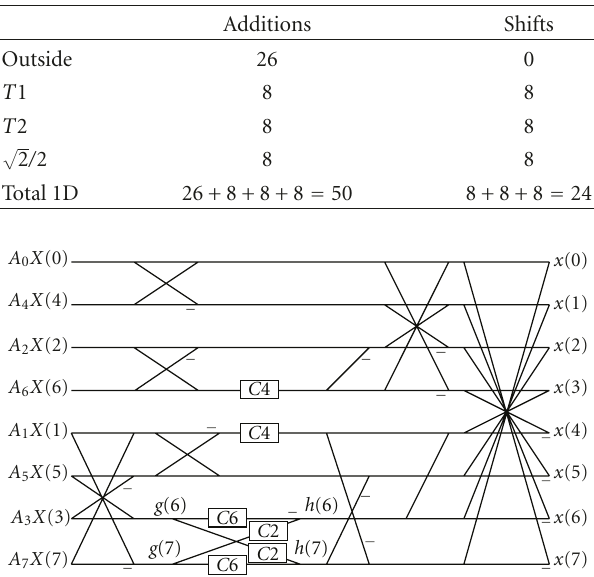
Table 1: The statistics of computational complexity.